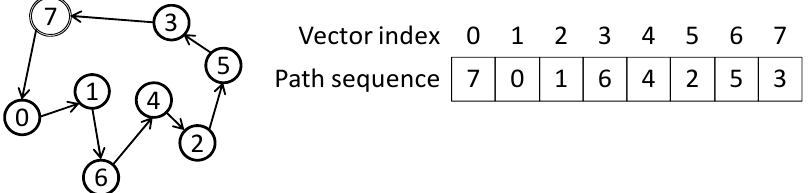
Figure 1. Representation of an individual solution.